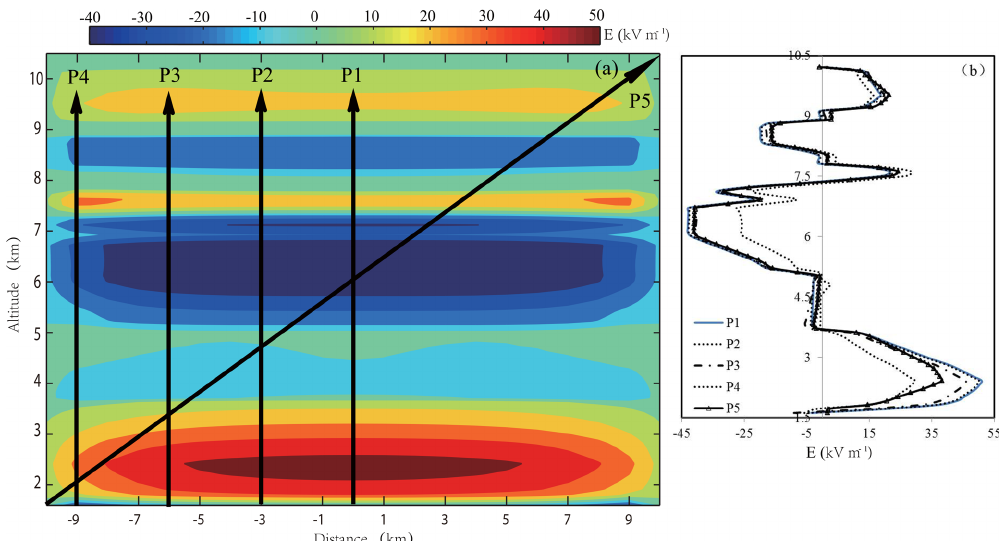
Figure 5. Model results of vertical E field by using the mean charge density in Fig. 4d, (a) vertical section across model center; (b) profiles of E field at different